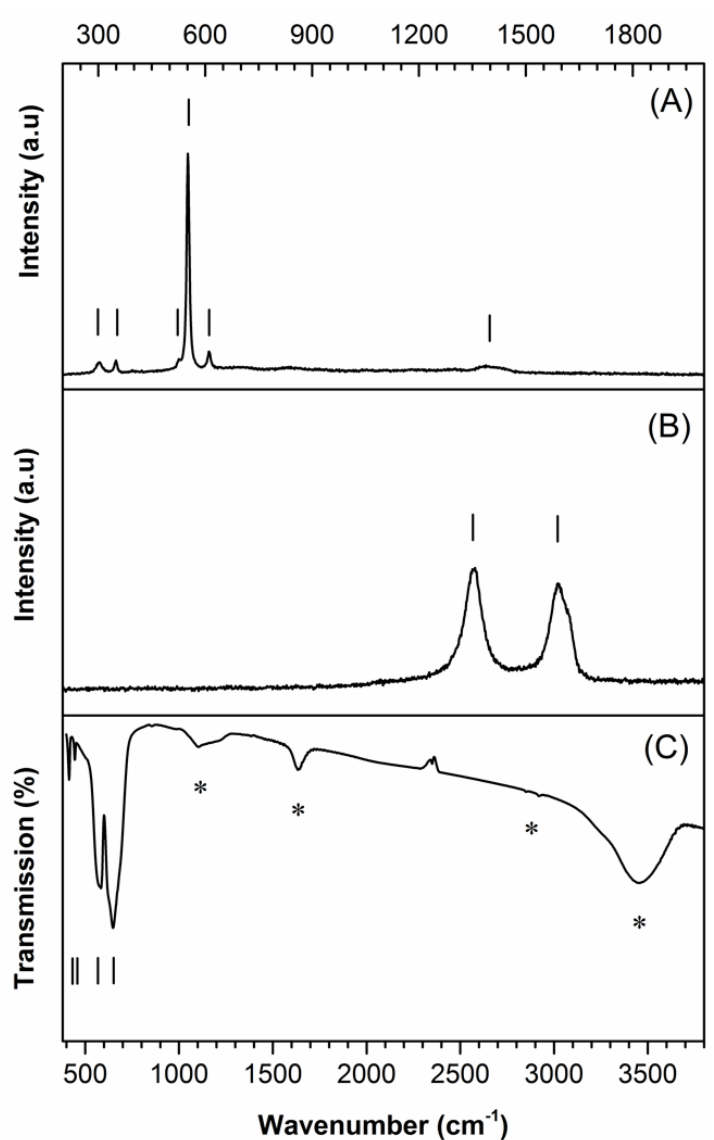
Figure 2. ( A , C ) Raman and Fourier transform infrared (FTIR) spectra, respectively, of the as-templated Cr 2 O 3 material and ( B ) the Raman spectrum of the carbon fiber that was used as template. In the FTIR spectrum of Cr 2 O 3 , all the vibration bands related to the chromium–oxygen bonds are noted by means of vertical lines, while a star symbol is used to identify the solvent traces and / or moisture that were adsorbed at the particles surface.